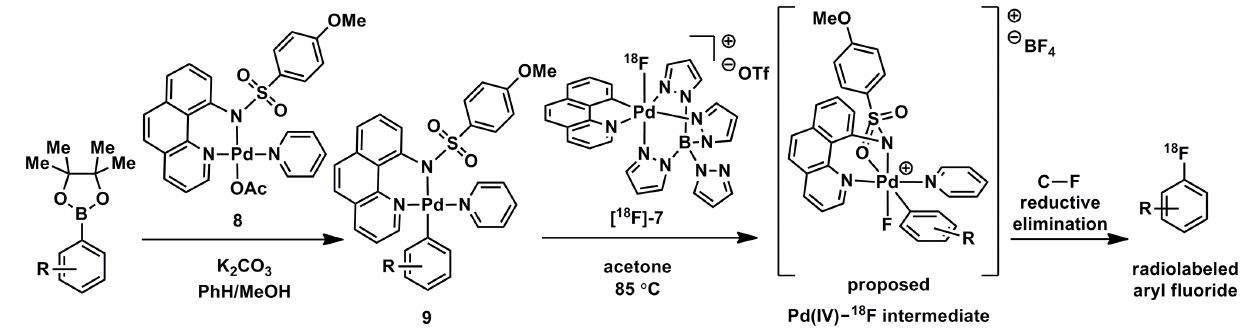
Figure 4. General palladium-mediated synthesis of radiolabeled aryl fluorides. C–F bond formation is proposed to occur by oxidation of 9 with [ 18 F]-7 leading to a proposed Pd(IV)– 18 F intermediate followed by C–F reductive